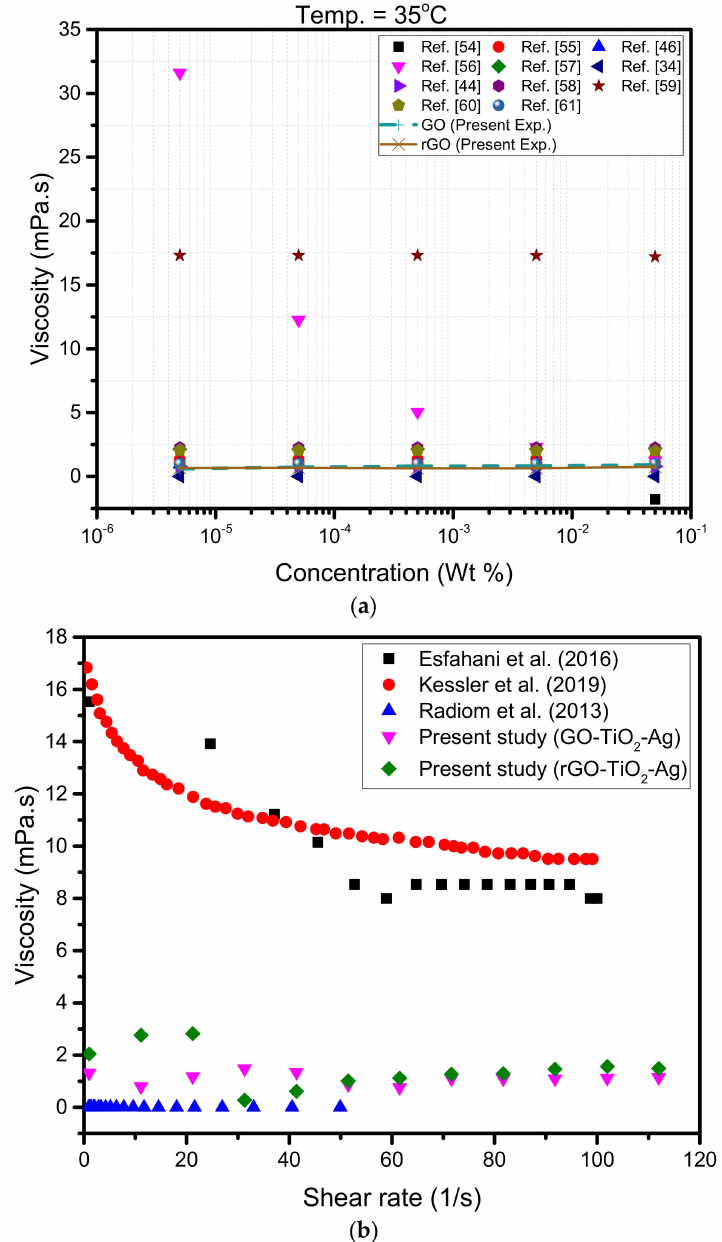
Figure 8. ( a ) Comparison of existing viscosity models with experimental results at 35 ◦ C and ( b ) comparison of experimental viscosity values from literature with current experimental results at 30 ◦